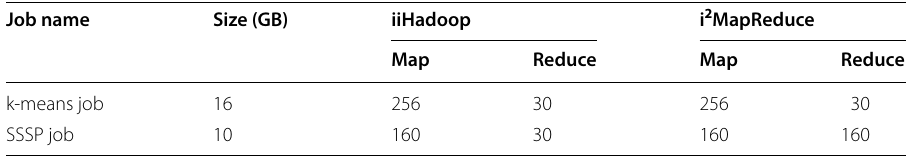
Table 2 Configurations of